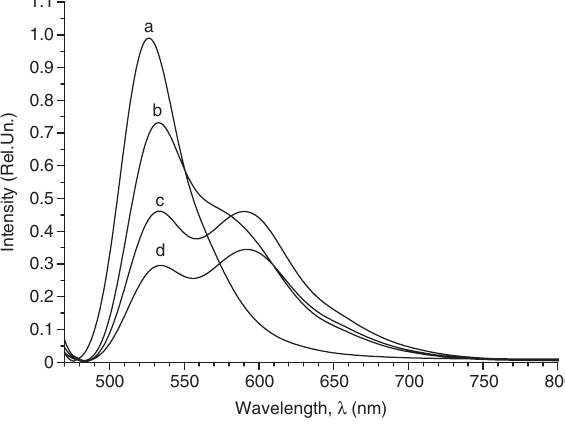
Figure 17 Influence of Cu(II) and laser irradiation ( λ = 457 nm) on electron excitation energy transfer effectiveness from AO to EB intercalated in DNA. (a) DNA-AO; (b) DNA-AO-EB; (c) DNA-AO-Cu(II); (d) DNA-AO-Cu(II) 10 min irradiation; (e) DNA-AO-Cu(II)-EB; (f) DNA- AO-Cu(II) 10-min irradiation+EB. [DNA] – 9.6 × 10 -4 mol/l (P), [AO]